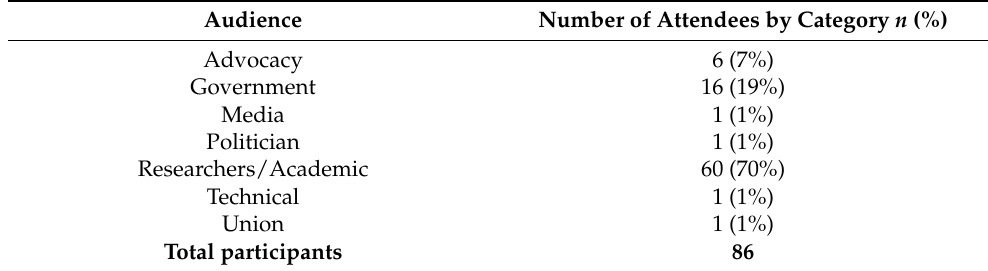
Table 1. Number of participants by